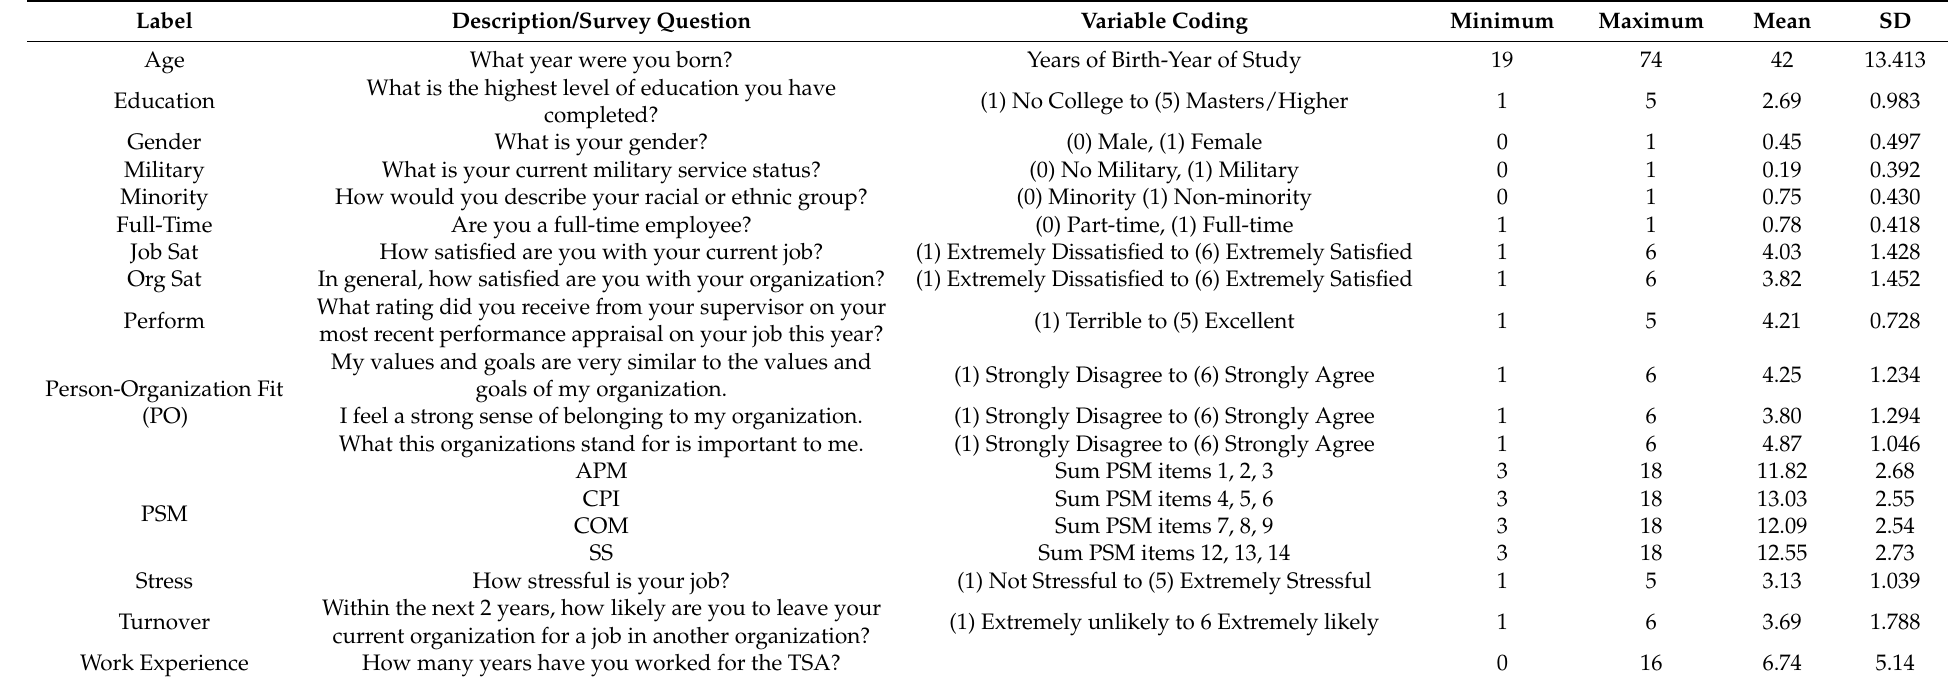
Table 1. Description of study variables (N =